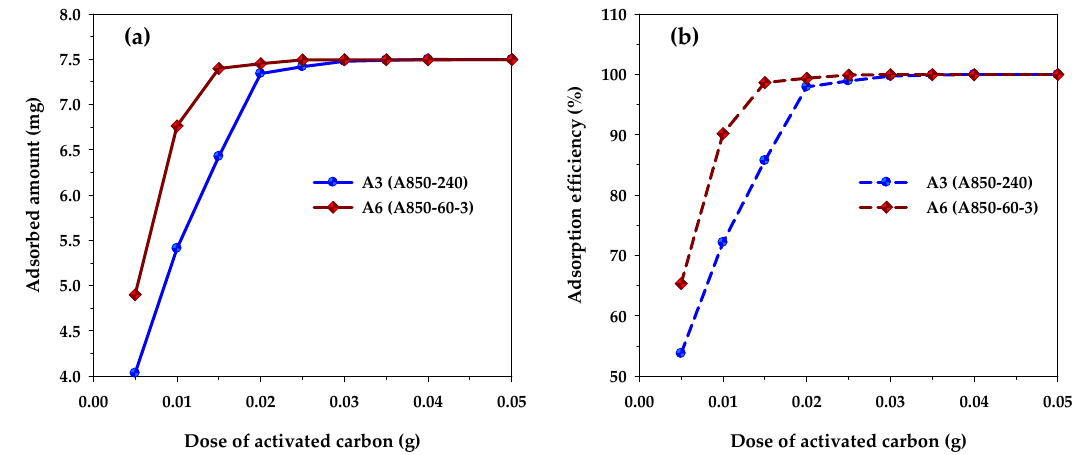
Figure 9. The effect of carbon dosage on ( a ) MB adsorption capacity and ( b ) MB removal efficiency for microporous (A3) and mesoporous (A6) activated carbons ( C 0 = 300 mg/L, V = 25 mL, and T = 35 °C).